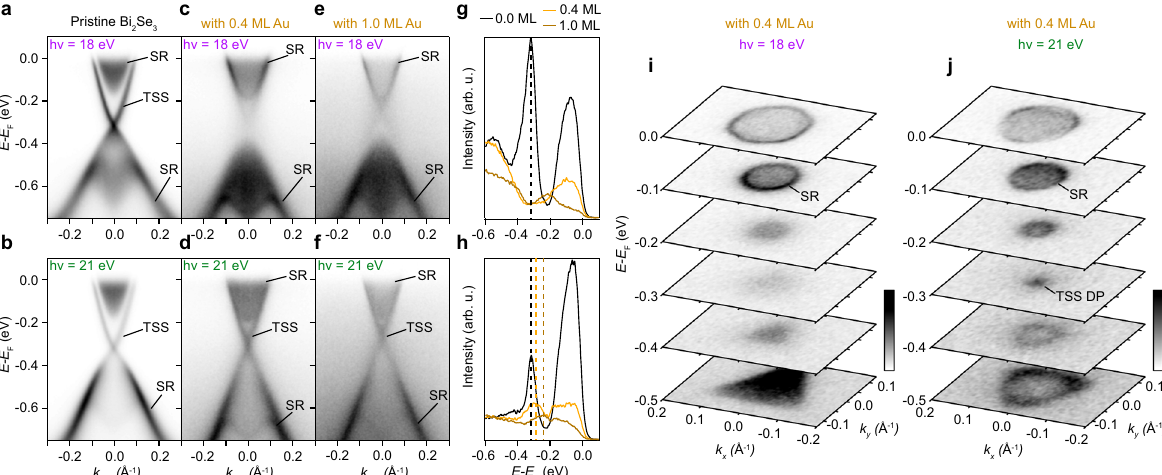
Fig. 2 Evolution of photoemission spectra following Au deposition. a – f Series of band dispersions of Bi 2 Se 3 along the Γ (cid:1) K direction following various levels of Au surface deposition [ a, b Pristine, c, d 0.4 monolayer (ML), e, f 1.0 ML]. g, h Energy-distribution curves (EDCs) through the Γ point for each deposition level. Dashed lines indicate the position of the Dirac point (DP) where applicable. The spectra in the top row ( a, c, e, g ) are taken with 18 eV incident photons and the spectra in the bottom row ( b, d, f, h ) are taken with 21 eV photons. Topological surface state (TSS) and surface resonances (SR) are labelled. i, j Constant energy k x − k y contours for i 18 eV and j 21 eV photons following 0.4 ML of Au deposition. Colour scales for photoemission intensity run from low (white) to high